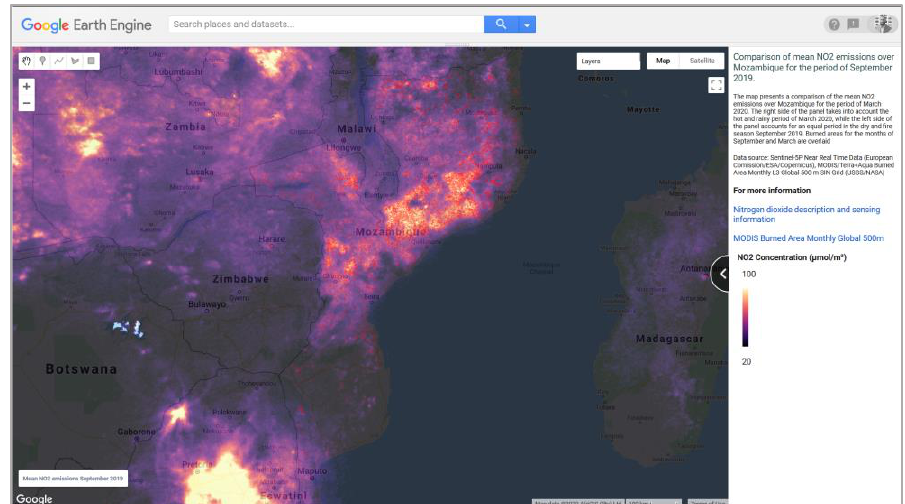
Figure 7. Example from a practical activity to monitor air quality as a result of wildfires using